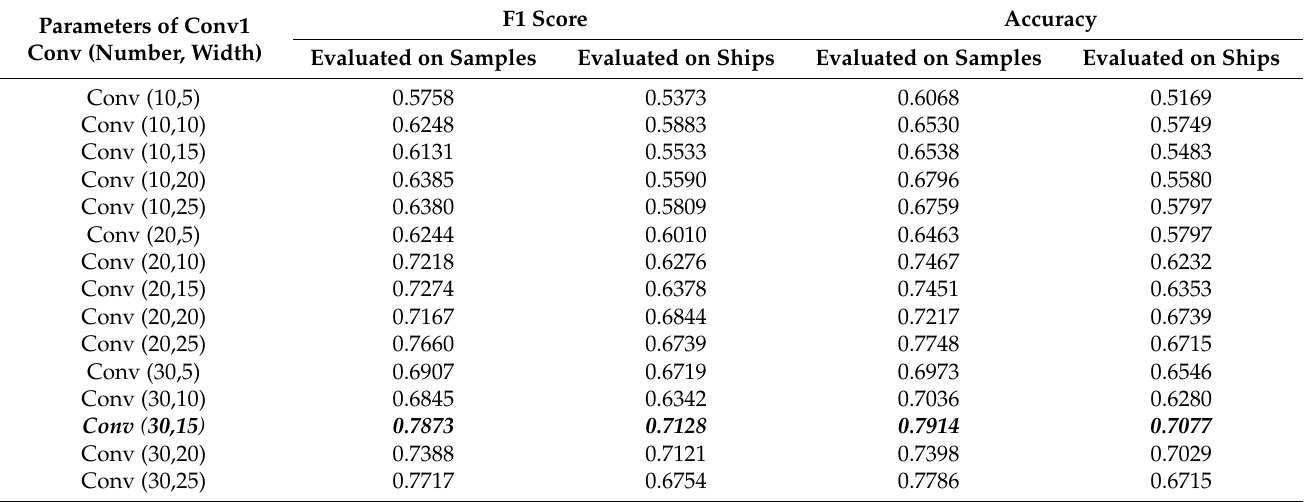
Table 9. Parameters of the first convolution layer.